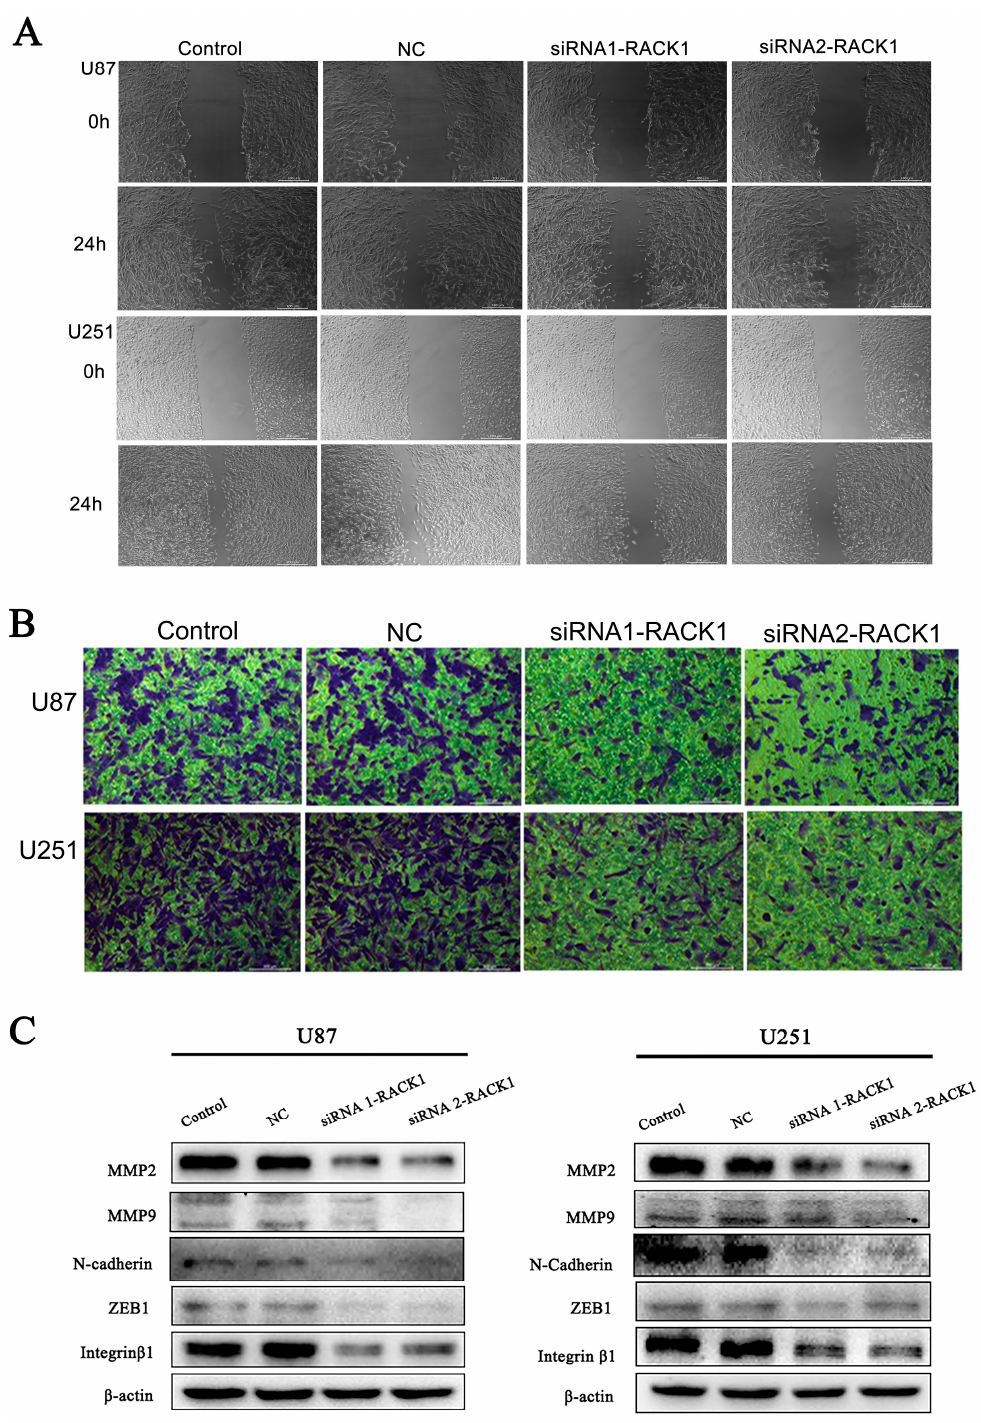
Figure 6. Downregulation of RACK1 inhibited the migration and invasion of glioma cells by suppressing epithelial-mesenchymal transition (EMT) markers. ( A , B ) Wound healing and transwell assays demonstrated that siRNA1-RACK1 and siRNA2-RACK1 could significantly inhibit cell migration and invasion in U87 and U251 cell lines, respectively, compared with NC groups; ( C ) Western blot analysis was performed to determine the expressions of EMT markers, such as MMP2, MMP9, N-Cadhenin, ZEB1, and Integrin β 1 in the U87 and U251 cell lines. Scale bar: 100 μ m. During tumorigenesis, the epithelial-mesenchymal transition (EMT) plays a crucial role in migration and invasion of various cancers, and the change of EMT protein levels was considered an